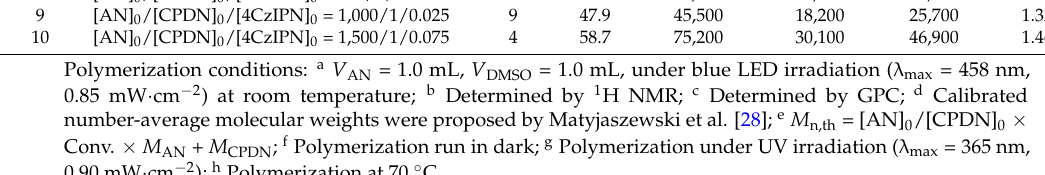
Polymerization conditions: a V AN = 1.0 mL, V DMSO = 1.0 mL, under blue LED irradiation ( λ max = 458 nm, 0.85 mW·cm − 2 ) at room temperature; b Determined by 1 H NMR; c Determined by GPC; d Calibrated number-average molecular weights were proposed by Matyjaszewski et al. [28]; e M n,th = [AN] 0 /[CPDN] 0 × Conv. × M AN + M CPDN ; f Polymerization run in dark; g Polymerization under UV